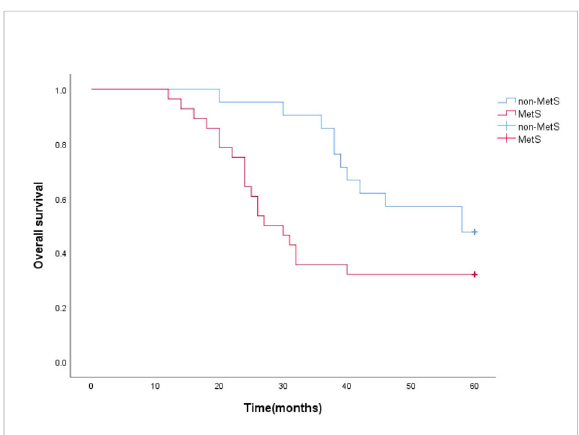
FIGURE 2 5-year survival curves for mPCA patients with MetS and non-MetS.